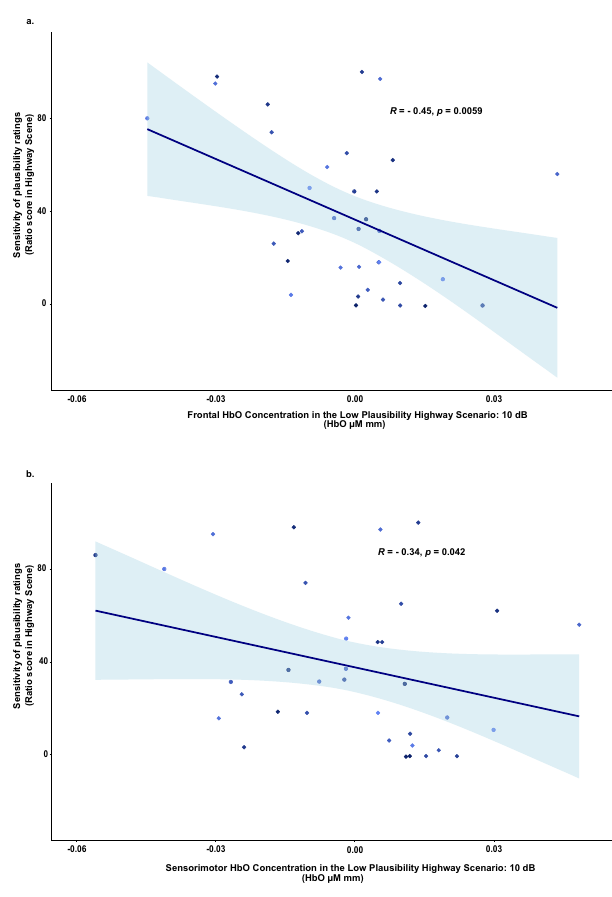
Fig. 6 Scatterplots showing negative correlations between cortical activities under the low plausibility scenario and the sensitivity of subjective ratings of perceived plausibility. a Results showing HbO concentration in the low plausibility scenario with smooth road surface (highway) in the frontal and premotor regions ( n = 35 young adults). b Results showing HbO concentration in the low plausibility scenario with smooth road surface (highway) in the sensorimotor cortex ( n = 35 young adults). Shaded area represents the 95% con fi dence